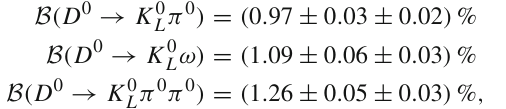
Fig. 1 Fits to the M 2 with D → π + π − π 0 tags (III) and with all other tags